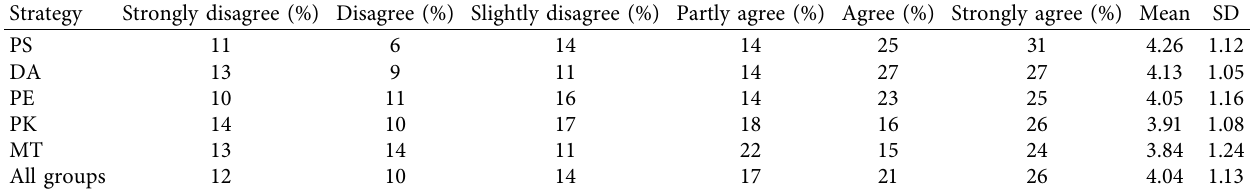
Table 4: Distribution of mean scores and SDs with females’ responses to MLCS (subscales) ( N � 116).